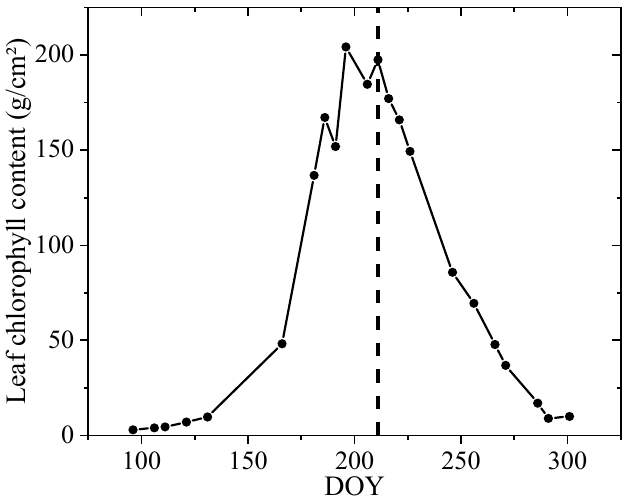
Figure 4. Time series of leaf chlorophyll content (CC) retrieved from Sentinel-2 by the Simplified Level 2 Product Prototype Processor (SL2P). The dashed line indicates day of year (DOY) 211, when CC began to decrease, i.e., leaf began to turn yellow in our study area.